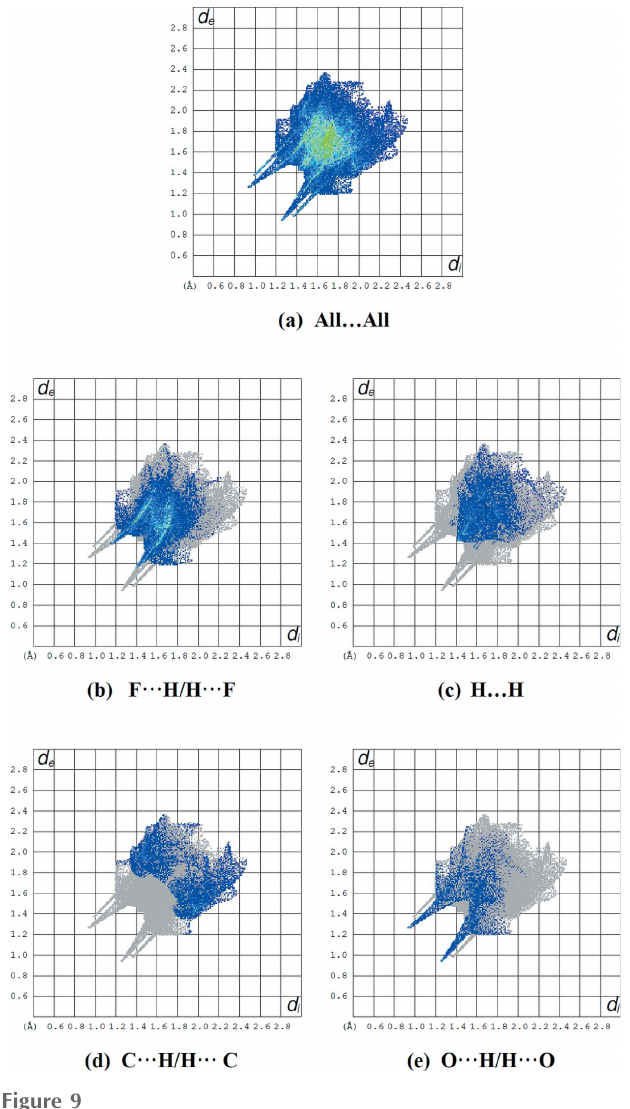
Figure 9 ( a ) The overall two-dimensional fingerprint plot and those